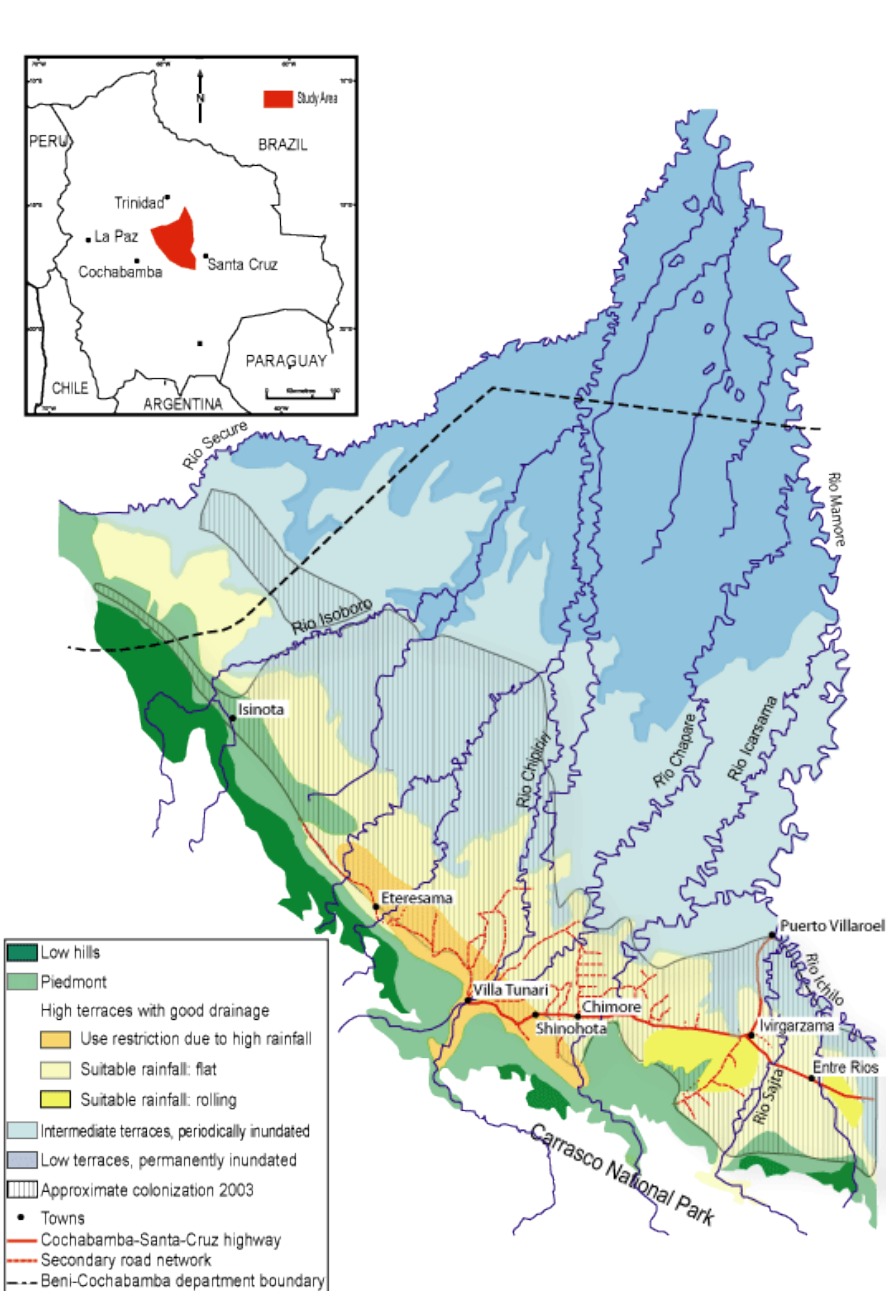
Fig. 1. Chapare: location